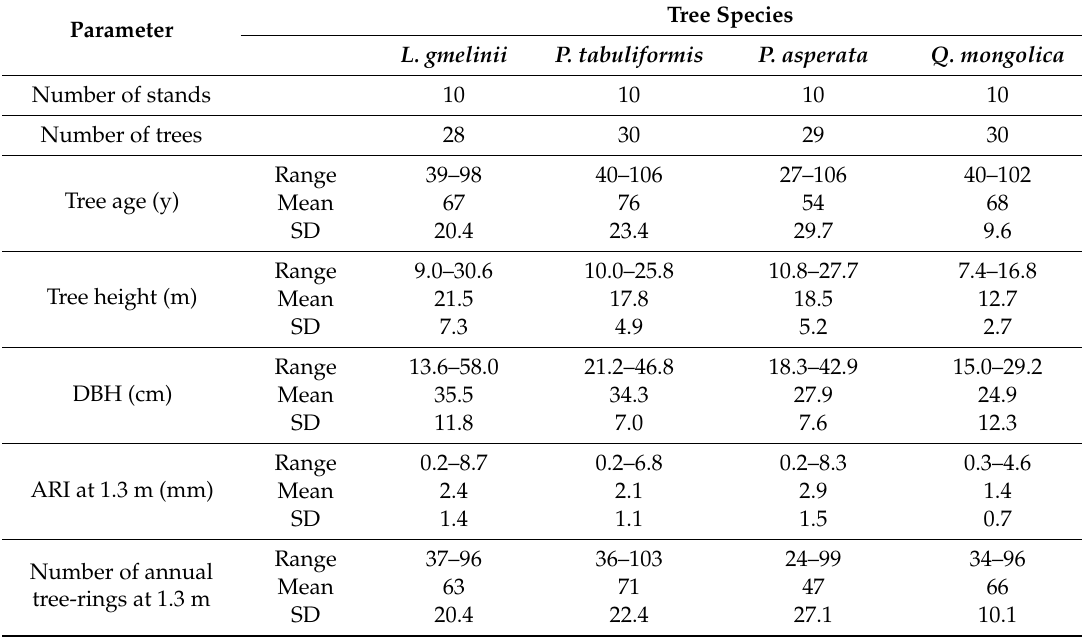
Table 2. Number of stands and trees for stem analysis for each tree species and figures for tree age, tree height, diameter at breast height (DBH), ARI and number of annual tree-rings at 1.3 m above ground. Tree Species Parameter L. gmelinii P. tabuliformis P. asperata Q.